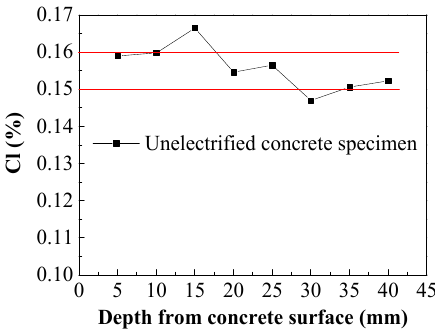
Figure 7. Initial chloride concentration in concrete.